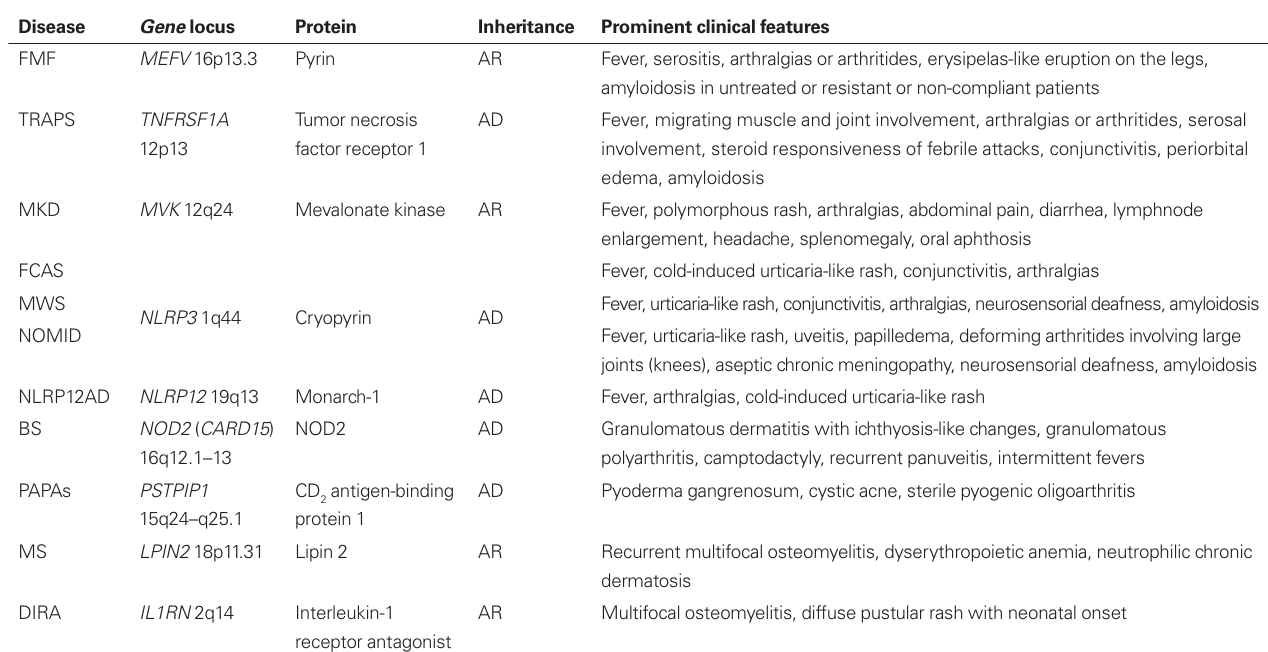
Table 1 | Summary of the main genetic and clinical features of monogenic autoinflammatory disorders.